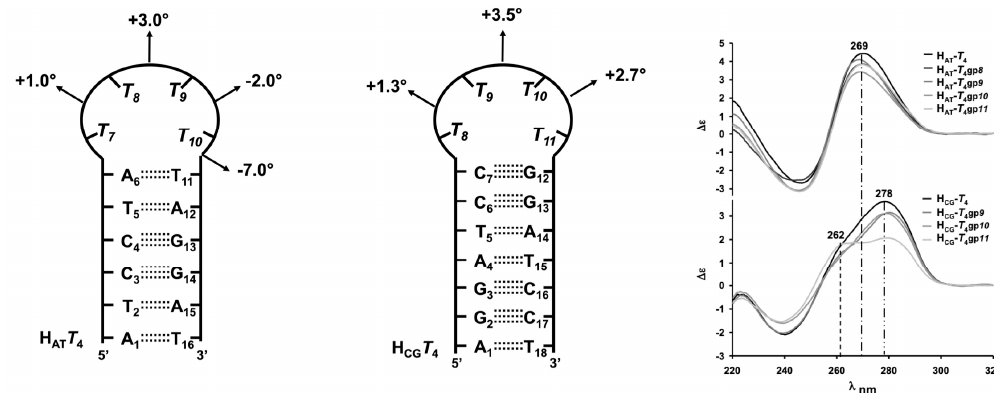
Figure 9. α , β -D-CNA (g + , t) within hairpin structures.